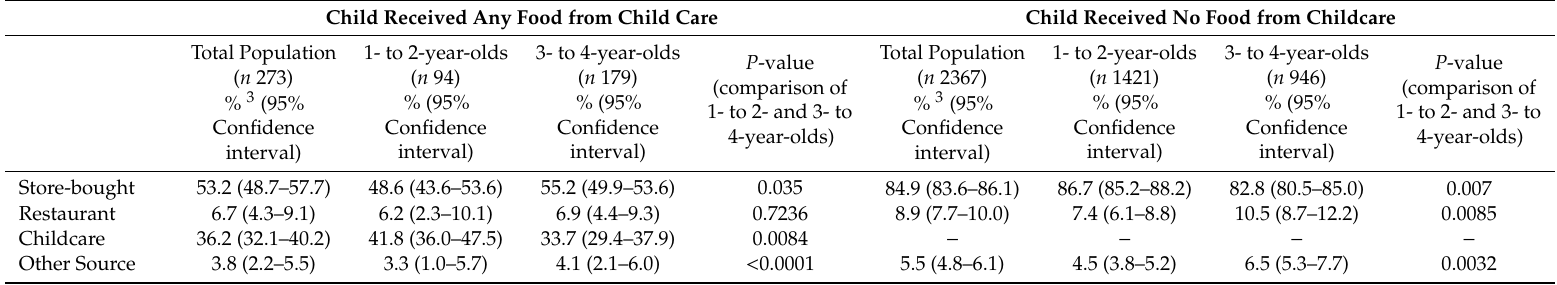
Table 2. Source 1 of all foods and drinks 2 reportedly consumed in a 24-h recall by children 1 to 4 years of age, National Health and Nutrition Examination Surveys, 2009–2014, n =